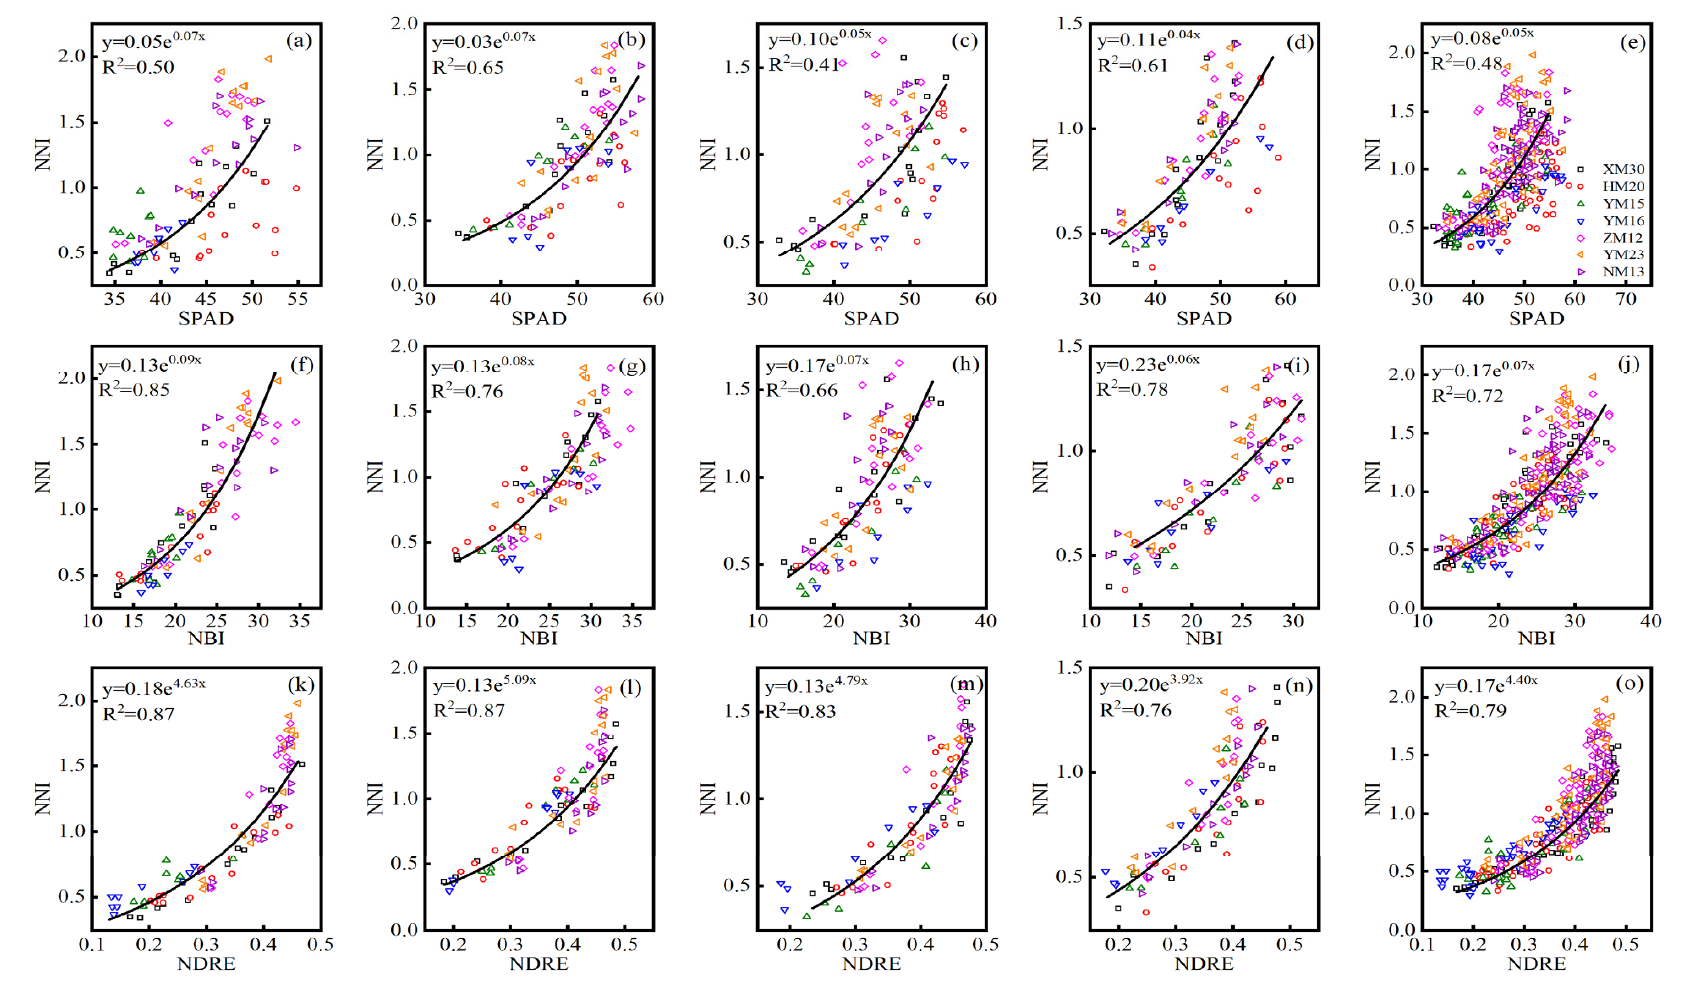
Figure 4. The exponential relationship between the SPAD and N nutrition index (NNI) across experiments 1–3 at ( a ) jointing, ( b ) booting, ( c ) flowering, ( d ) filling, and ( e ) all growth stages/the exponential relationship between the NBI and N nutrition index (NNI) across experiments 1–3 at ( f ) jointing, ( g ) booting, ( h ) flowering, ( i ) filling, and ( j ) all growth stages/the exponential relationship between the NDRE and N nutrition index (NNI) across experiments 1–3 at ( k ) jointing, ( l ) booting, ( m ) flowering, ( n ) filling, and ( o ) all growth stages. Black lines indicate regression lines.